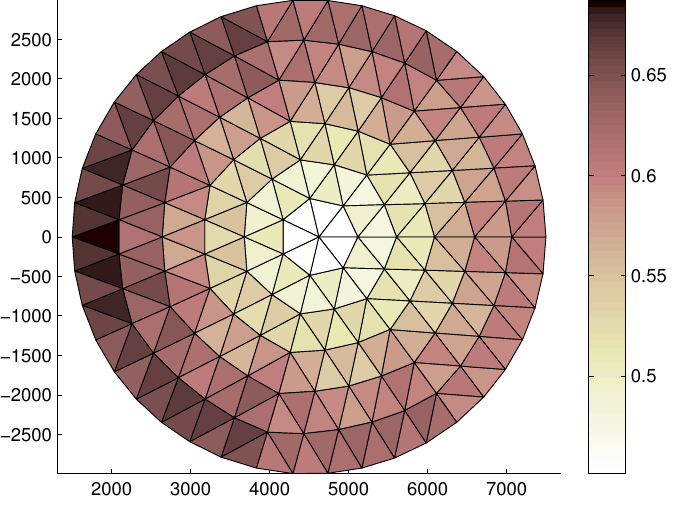
Figure 9. Faceted RMS (mm) of the front tension truss in the initial